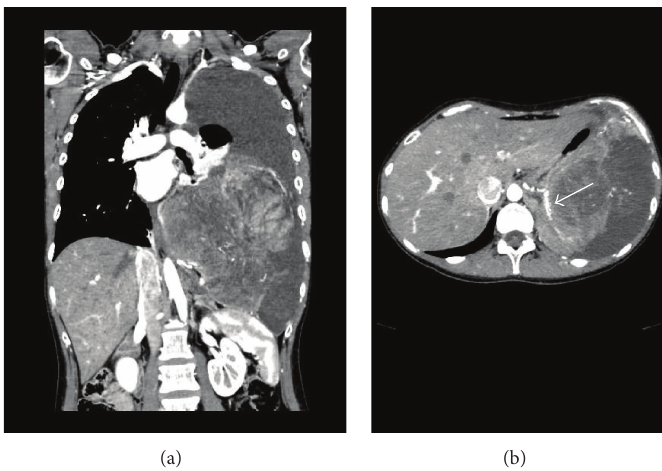
Figure 1: (a) Chest contrast-enhanced computed tomography (CT) showing the bulky intrathoracic mass opacity on the left. (b) The inferior phrenic artery was found to be the main nutrient vessel in the contrast-enhanced CT (arrow).